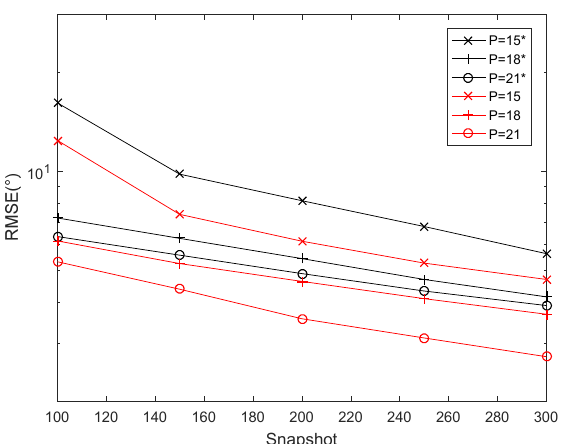
Figure 17. RMSE performance of η versus the number of snapshots.